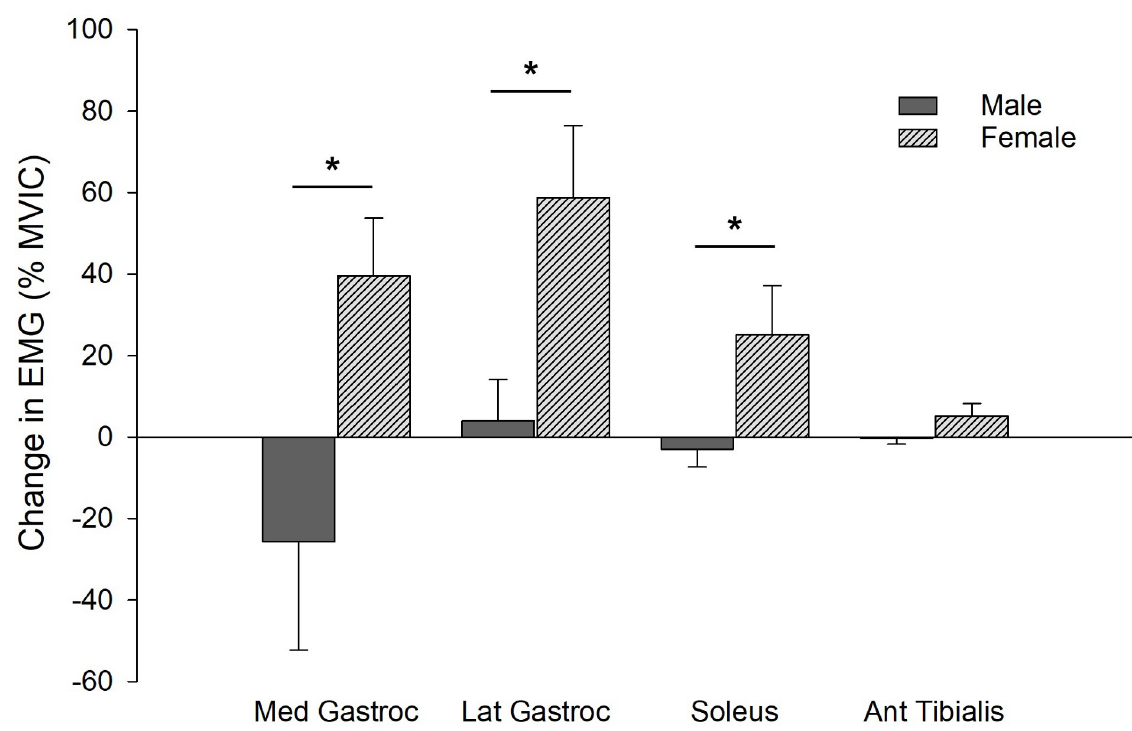
Fig 4. Change in RMS EMG amplitude for each the soleus, medial and lateral gastrocnemius, and tibialis anterior muscles from the start to end of the SLHR task, as a percent of baseline MVIC. EMG for all three plantar flexor muscles increased in females (striped bars). In males (solid bars), medial gastrocnemius EMG decreased, while lateral gastrocnemius and soleus EMG remained unchanged. Tibialis anterior EMG remained unchanged in both males and females. � , interaction between sex and time, p < 0.05.